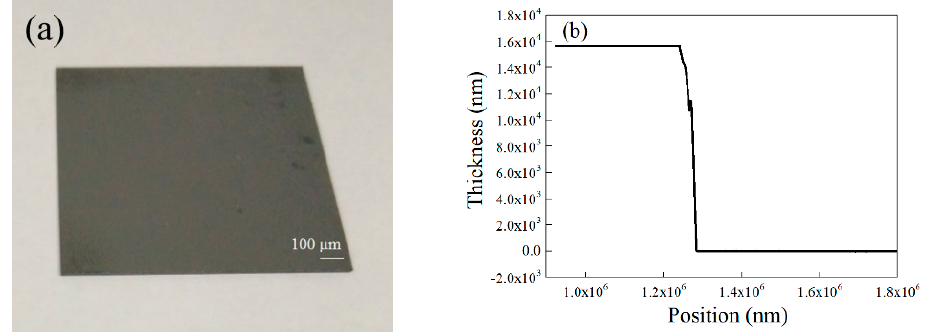
Figure 1. ( a ) Micrograph and ( b ) thickness of the ultra-thin silicon